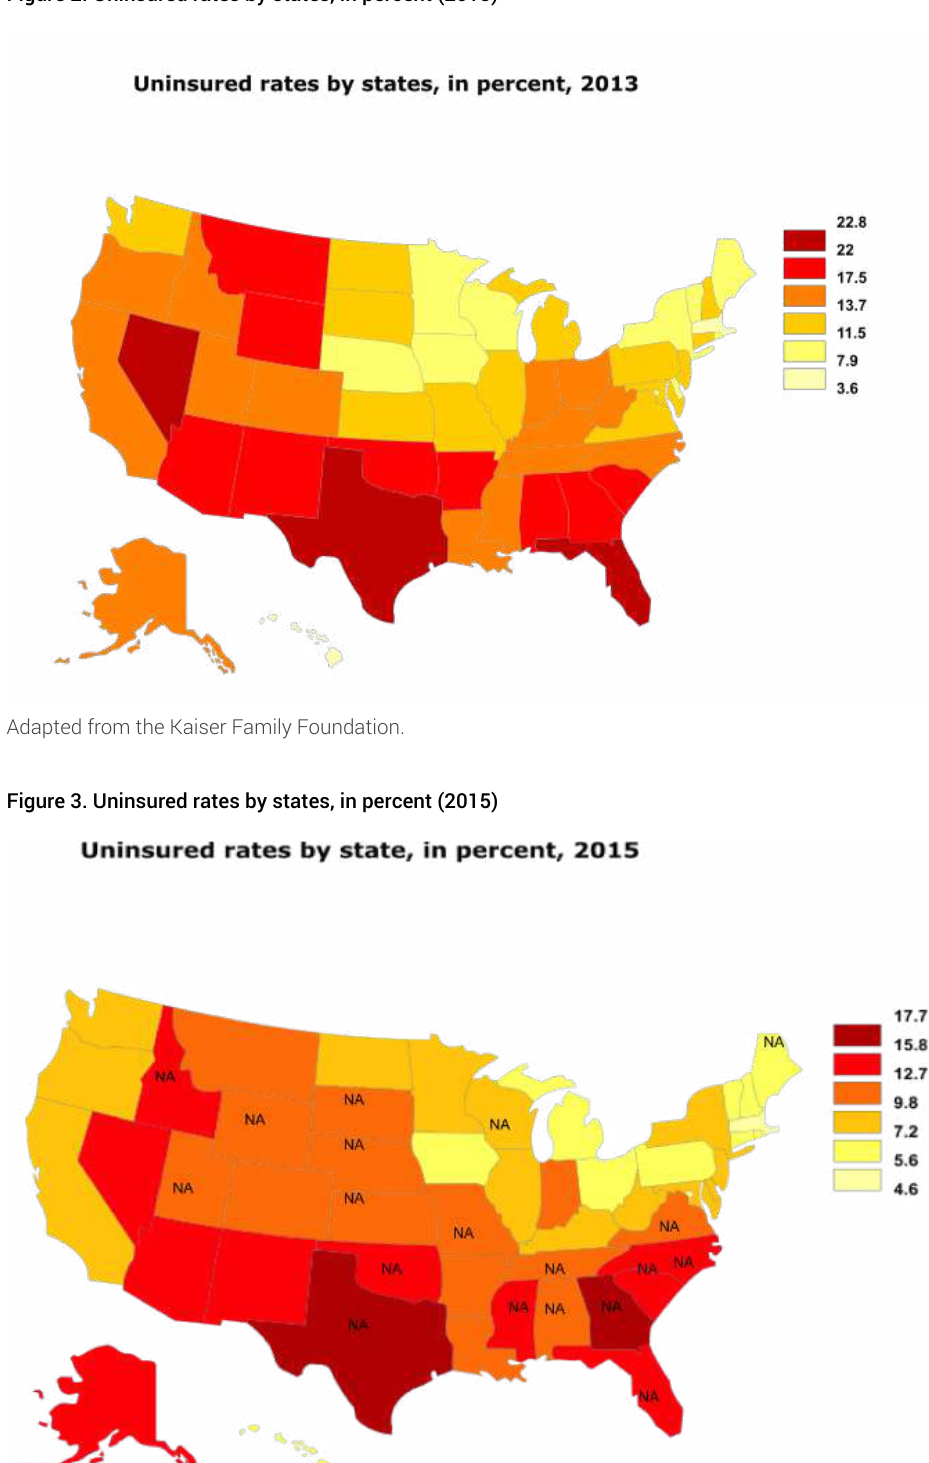
Figure 2. Uninsured rates by states, in percent (2013)